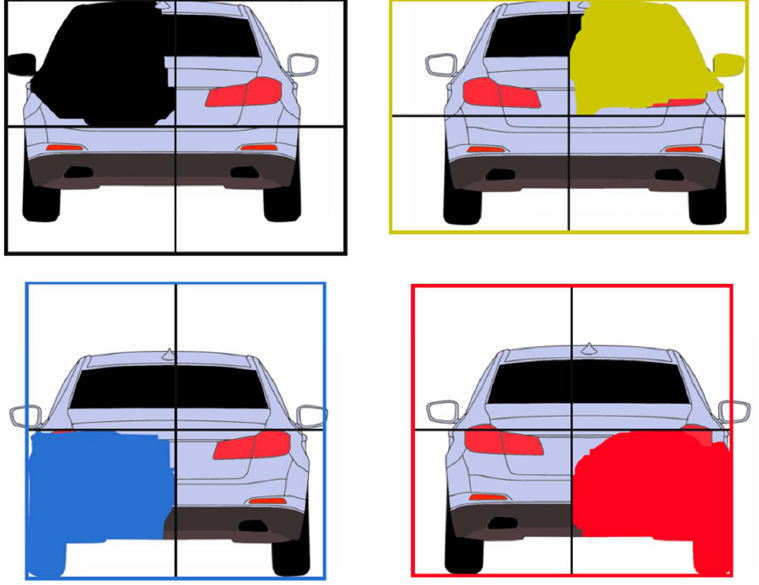
Figure 9. Generation of rectangle hypotheses, based on quarters.